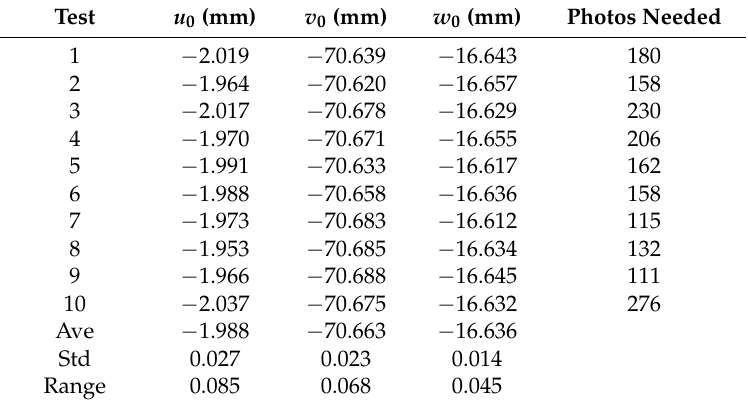
Table 1. Repeatability test of self-calibration for ( u 0 , v 0 , w 0